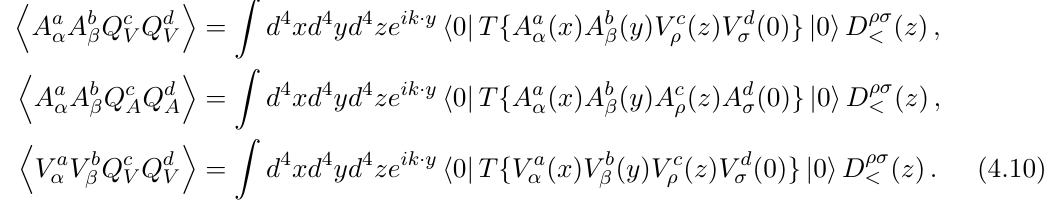
Figure 1 . Diagrammatic representation of be represented in a similar